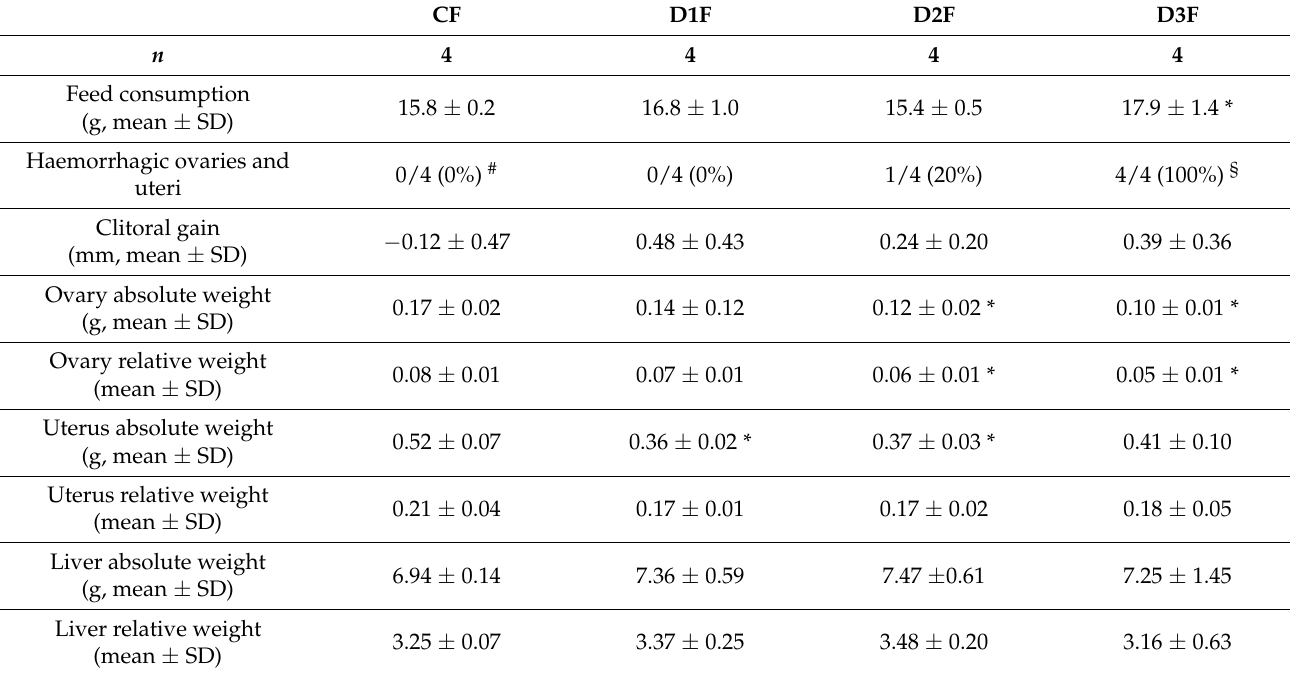
Figure 3. Body weight (bw) of female rats subcutaneously treated with different doses of testosterone enanthate two times a week, for 2 weeks: CF: 0 — sesame oil; D1F: 0.45; D2F: 0.95; D3F: 2.05 mg. Panel ( A ) bw gain and ( B ) bw at treatment days 5, 8, 12 and 13. Data are presented as mean ± standard deviation. Statistical significance: * p < 0.05 Mann–Whitney test. Table 2. General toxicity data of female rats subcutaneously treated with different doses of testos- terone enanthate two times a week, for 2 weeks: CF 0 — sesame oil; D1F 0.45, D2F 0.95 and D3F 2.05 mg. Statistical significance: § p < 0.05 Fisher exact test; # p < 0.05 linear trend; * p < 0.05 Mann–Whitney test. n : number. SD: standard deviation.